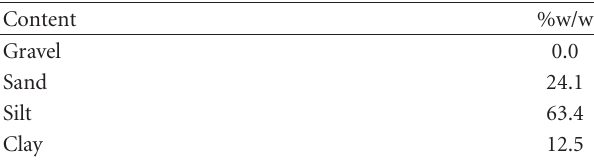
Table 2: Content of the soil sample.